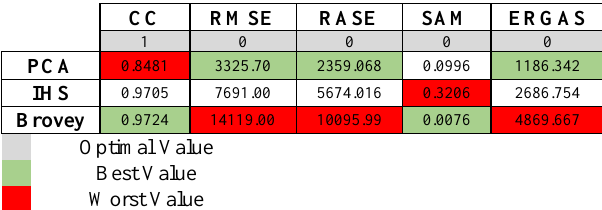
Table 3. Metric results for RASAT pan-sharpened images According to Table 3, speaking statistically, PCA method resulted in the most consistent pan-sharpened image. On the other